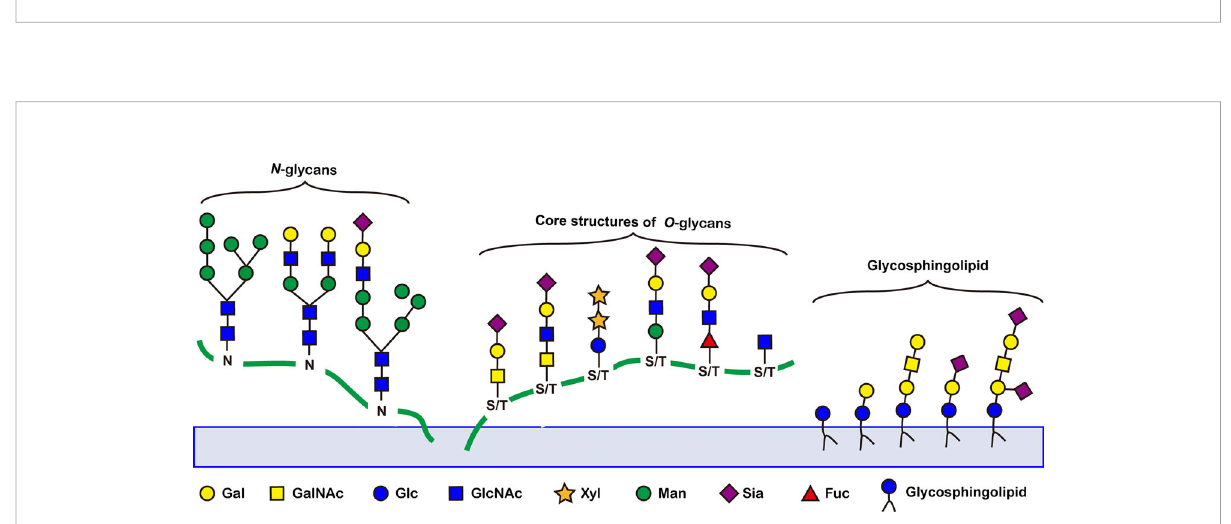
FIGURE 2 Representative tumor-associated aberrant glycosylation. O-glycan truncation, sialylation, fucosylation, and N-linked glycan branching are abnormally present in cancer and contribute to cancer growth and